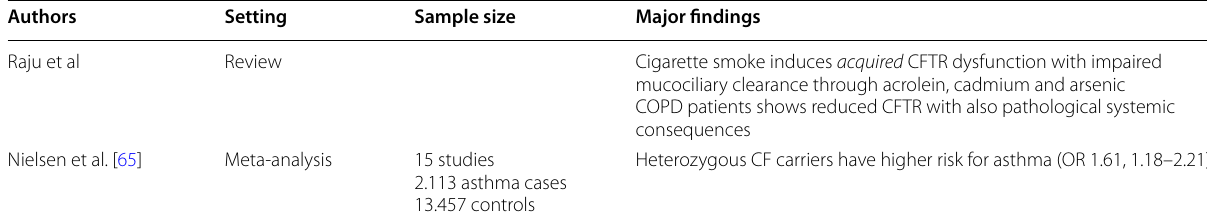
Table 3 Summary of main studies about CFTR and lung diseases